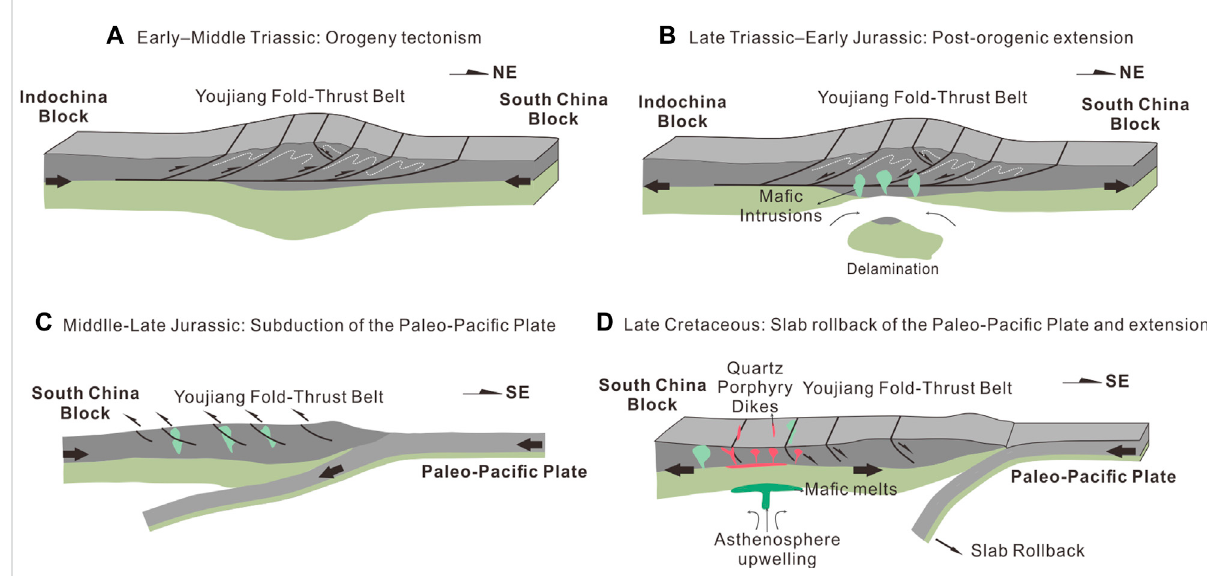
FIGURE 8 Tectonic model for the Mesozoic evolution of YFTB. (A) Collision between the Indochina block and SCB results in a series of NE-verging fold- and-thrust faults. (B) The delamination and post-collision rework the pre-existing structures and lead to the intrusion of ma fi c rocks. (C) The subduction of the Paleo-Paci fi c oceanic plate produces the N(N)E-striking faults that crosscut pre-existing structures and ma fi c rocks. (D) The rollback of the Paleo-Paci fi c plate leads to the back-arc extension setting and felsic dykes ’ emplacement. Modi fi ed from Qiu et al. (2019), Yang et al. (2021), and Zhang X. M. et al.